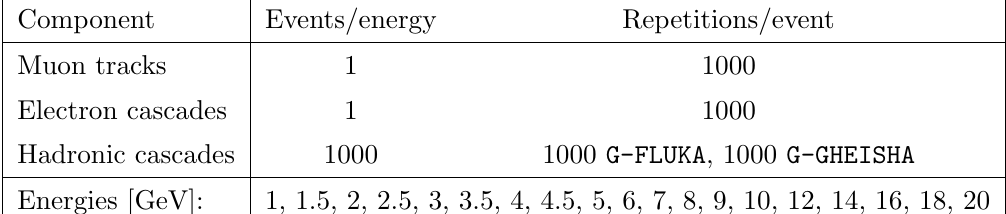
been studied. For hadronic cascades with E higher light yield (cf. (cid:12)gure 4) and (cid:24) 10% less (cid:13)uctuations than G-GHEISHA .